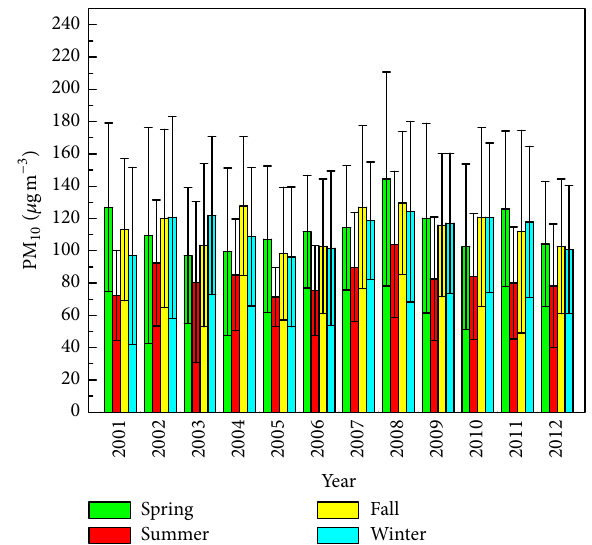
Figure4:SeasonalvariationsofPM 10 concentrationinHefeiduring 2001–2012. The error bars indicated the standard deviation for the average PM 10 concentration value in each season every